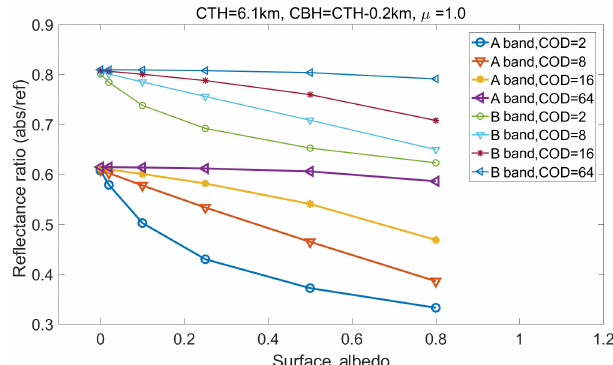
Figure 4. Ratio of simulated reflectance measurements for EPIC A and B absorption band to the reference band with different surface